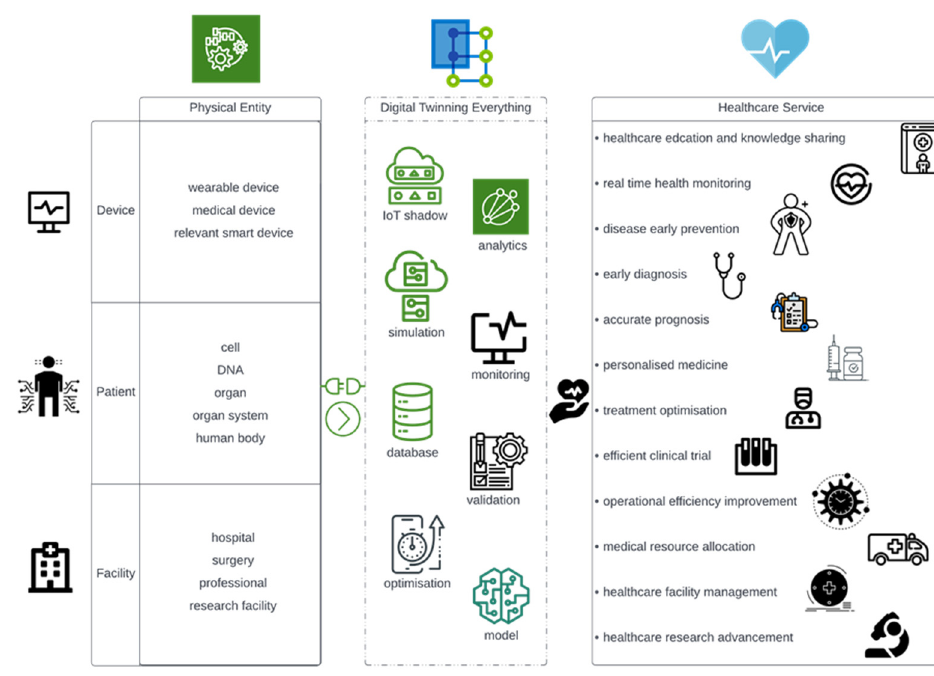
Figure 3. Digital twinning everything as a healthcare service.